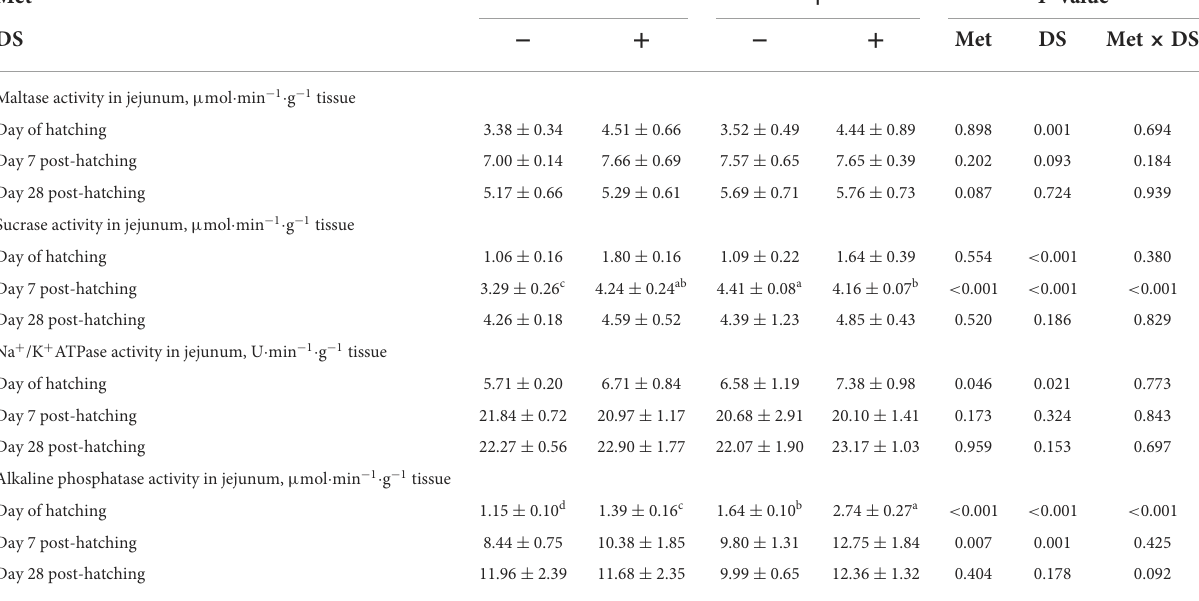
TABLE 10 Effects of in ovo injection of methionine (Met) and disaccharide (DS) on jejunum digestive enzymes parameters of geese during the early-life post-hatching a,b . Met − + P -value